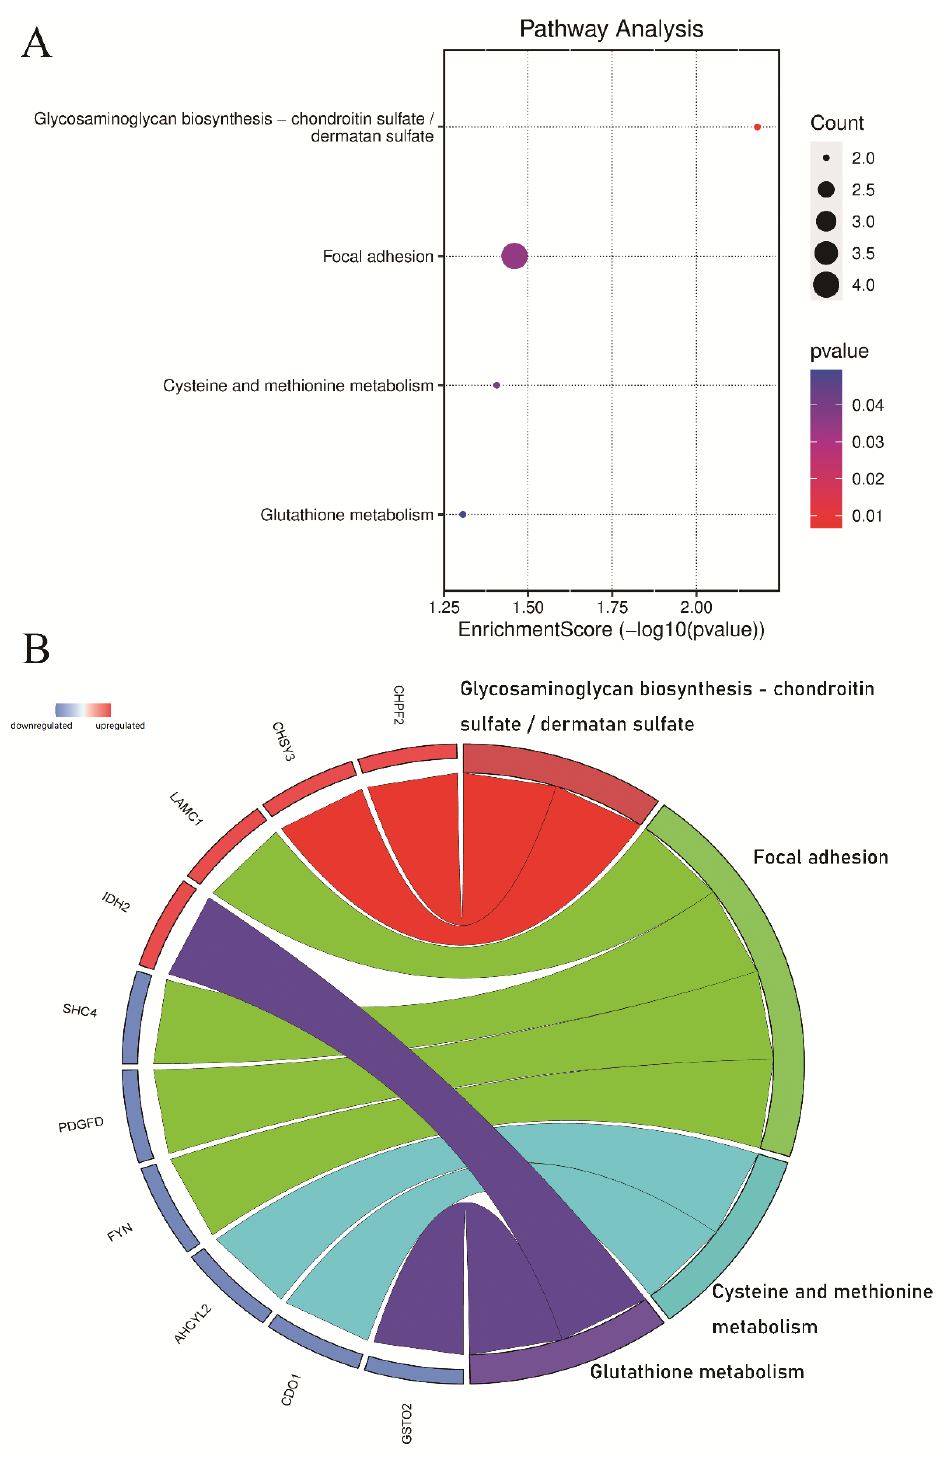
Figure 3. Kyoto Encyclopedia of Genes and Genomes (KEGG) pathway analysis of DEGs. ( A ) Ad- vanced bubble chart shows enrichment of DEGs in signaling pathways. The x -axis label represents the gene ratio, and the y -axis label represents the pathway. ( B ) Chord plot shows the distribution of DEGs in different KEGG pathways. Symbols of DEGs are presented on the left side of the graph. Symbols in red represent upregulated genes, and blue represents downregulated genes. Gene involvement in the KEGG pathways is indicated by colored connecting